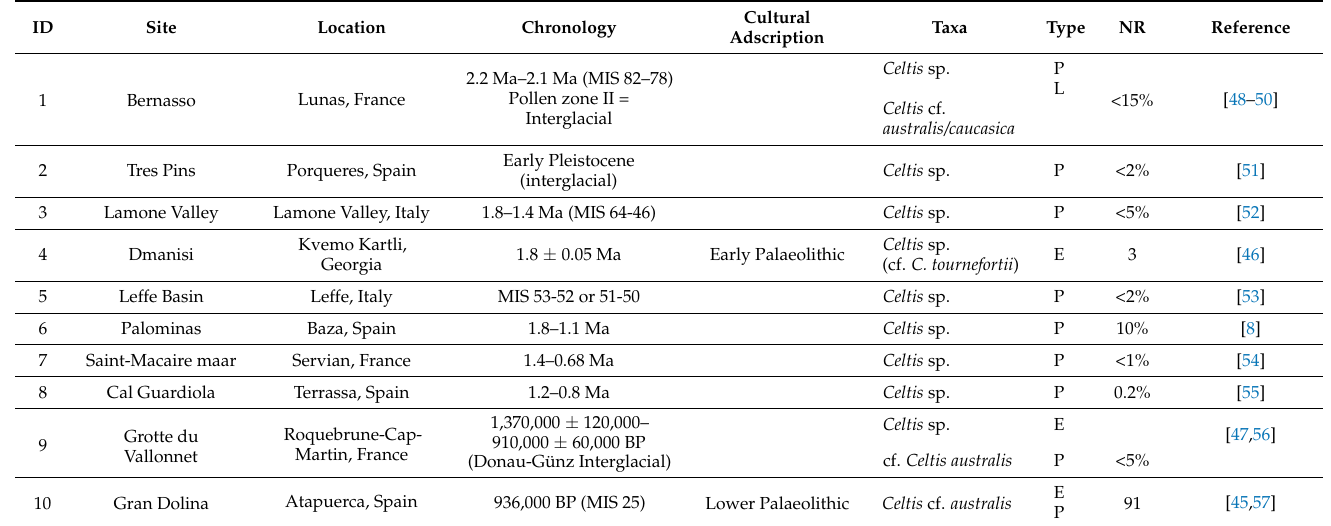
Table 1. Lower Pleistocene sites where Celtis remains were reported (types of remains: endocarp (E), leaves (L), pollen (P)).